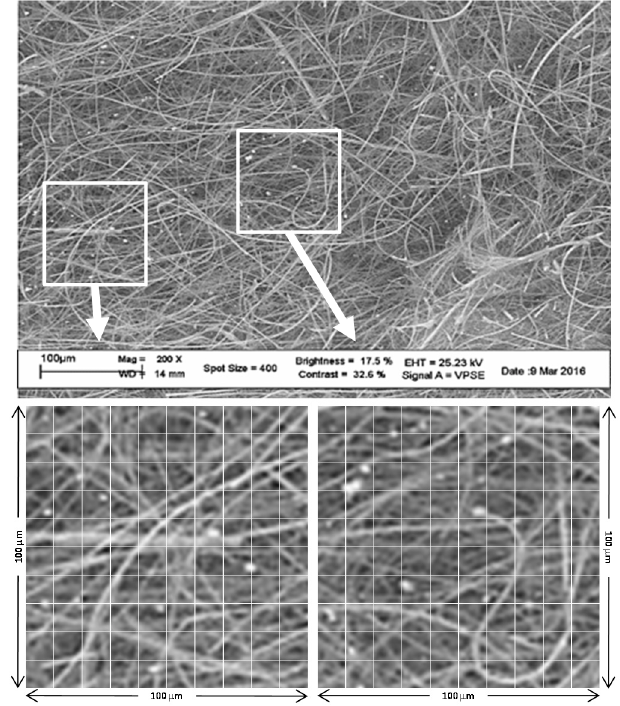
Figure 10. SEM image of one filter with particles. Particle size analysis from SEM images pointed out that the average particle dimension was lower than 3 μ m. Large particles were rare in museum air.